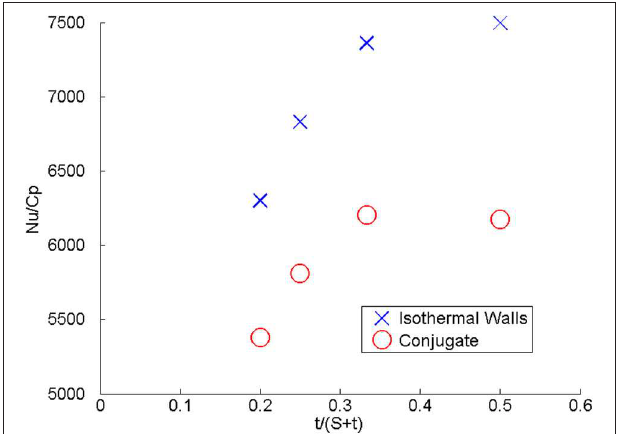
FIGURE 11 | CFD results compared to model given by Equations 4 and 5. (A) S/H (cases 4, 7–9). (B) t/H (cases 7, 10, 11). (C) C/H (cases 1–6). FIGURE 12 | Effects of S/H on Nu/Cp (cases 4,